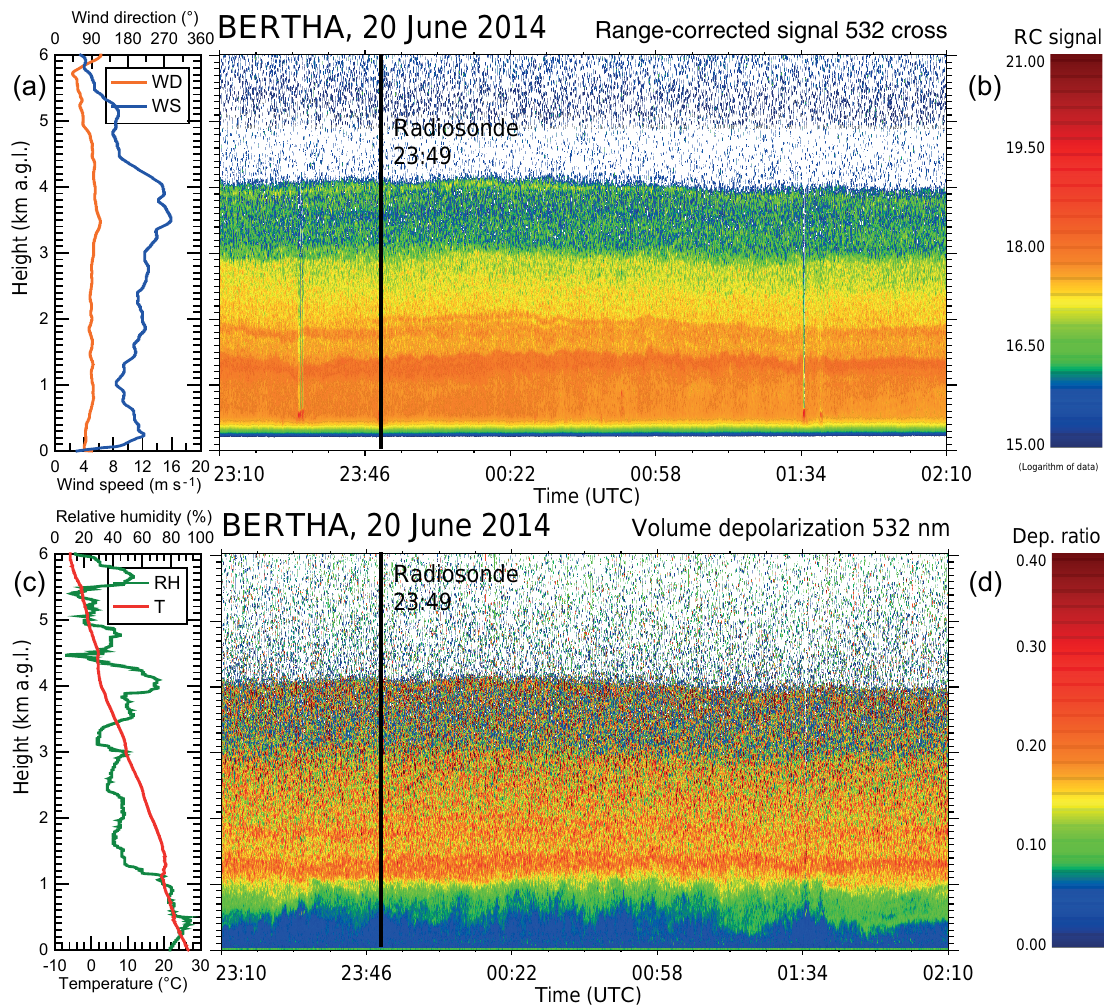
Figure 7. Saharan air layer (from 1 to 4km height) above the marine boundary layer. The same parameters as in Fig. 2 are shown. The lidar observation was performed on 20 June 2014, 19:10–22:10LT. The radiosonde was launched at 19:49LT (indicated by black vertical